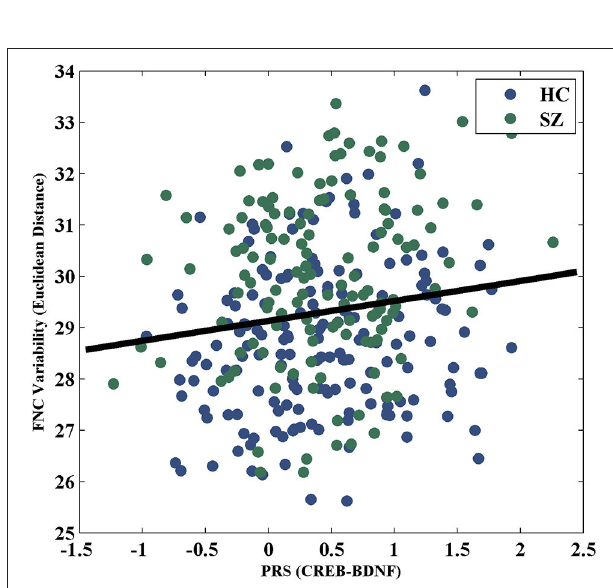
FIGURE 6 | Scatterplot of PRS of CREB-BDNF SNPs and FNC variability measured with Euclidean distance.